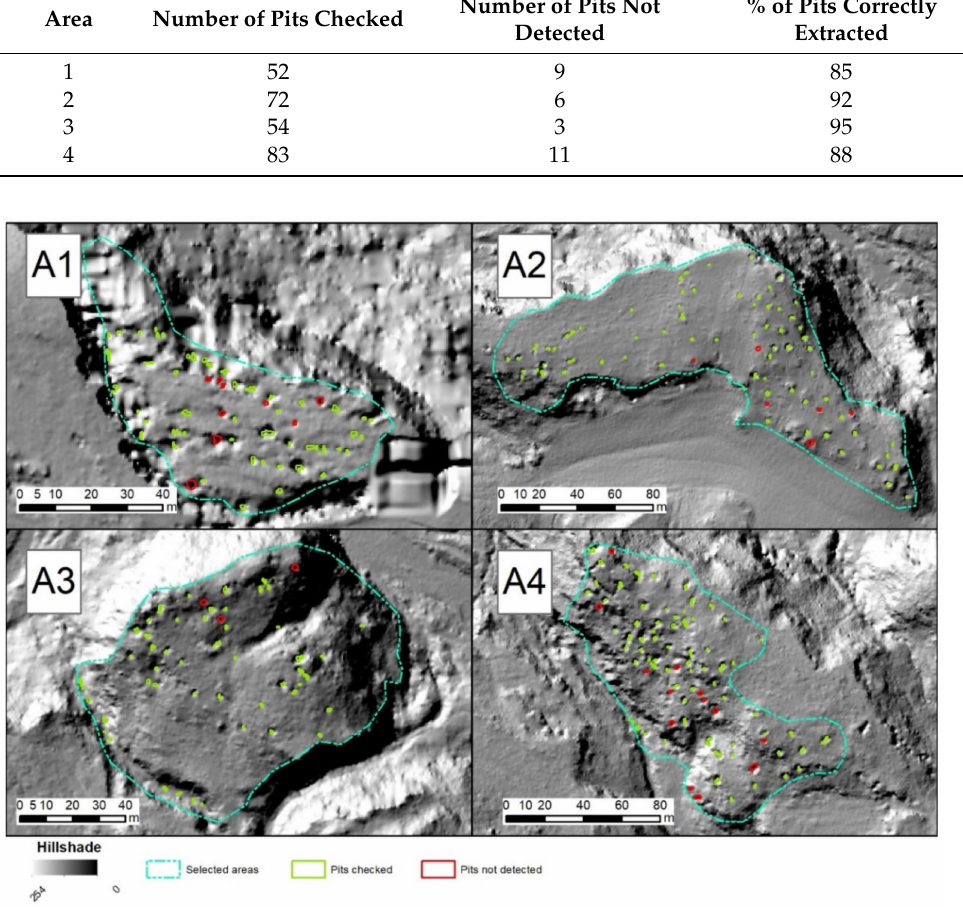
Figure 10. Validation of results. Pits extracted with Geomorphon and validated (checked, in green) and pits not detected (in red) for each of the four selected